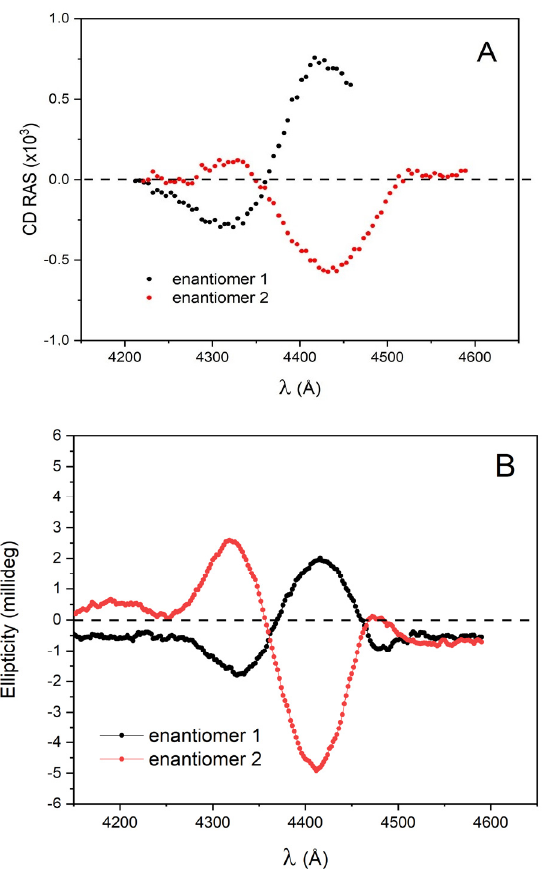
Figure 7. Panel ( A ): CD-RAS experimental spectra for sample C1 (red curve: enantiomer 1) and sample C2 (black curve: enantiomer 2) (see text). The two enantiomers were obtained from a 50 µ L droplet of a ZnOEP solution in dichloromethane deposited onto a glass substrate and measured in transmission mode. The resulting film has an average thickness estimated in the range of 10–15 nm from atomic force microscope images (not shown). Panel ( B ): Ellipticity spectra measured on the same samples by a commercial spectrometer for circular dichroism for sample C1 (red curve: enantiomer 1) and sample C2 (black curve: enantiomer 2).